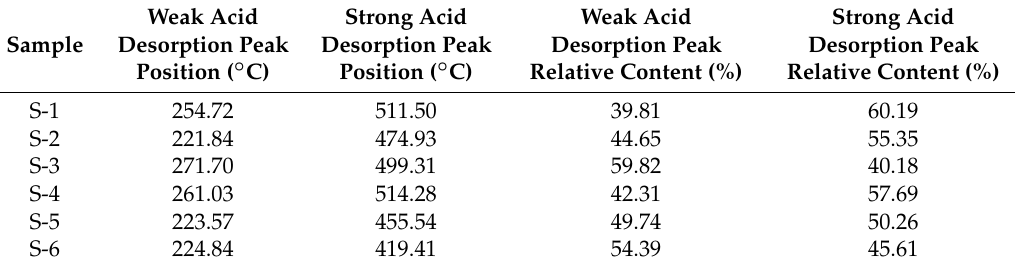
Figure 4. The NH 3 –TPD profiles for the calcined SAPO-34 catalysts. Table 3. The acid distribution for samples synthesized with different gel compositions.